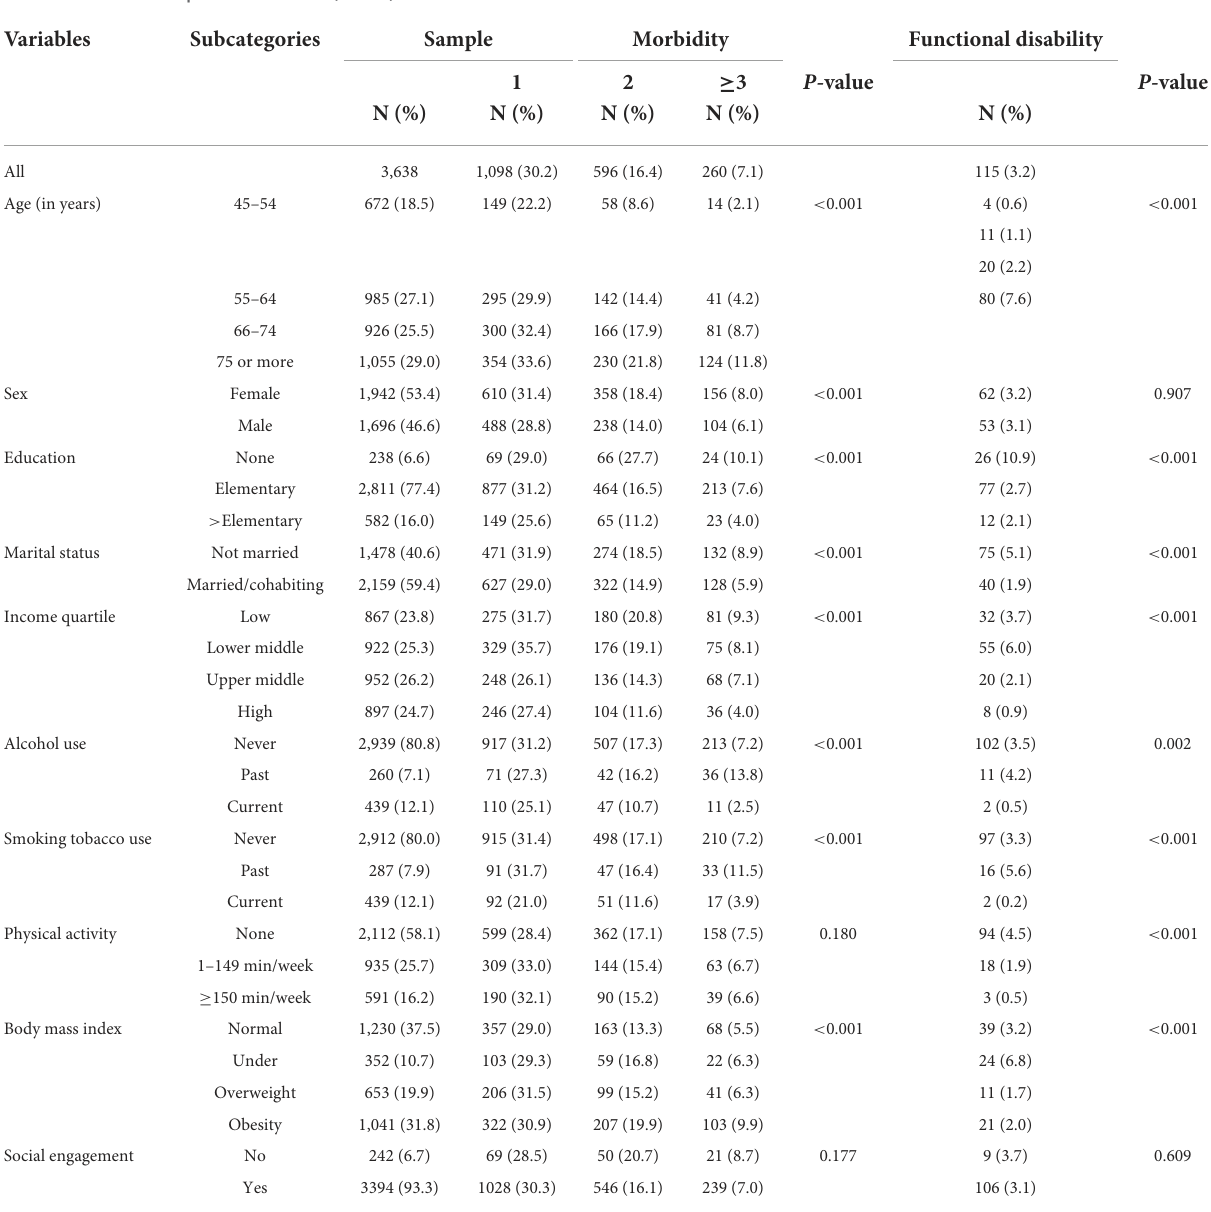
TABLE 1 Baseline sample characteristics, HART,